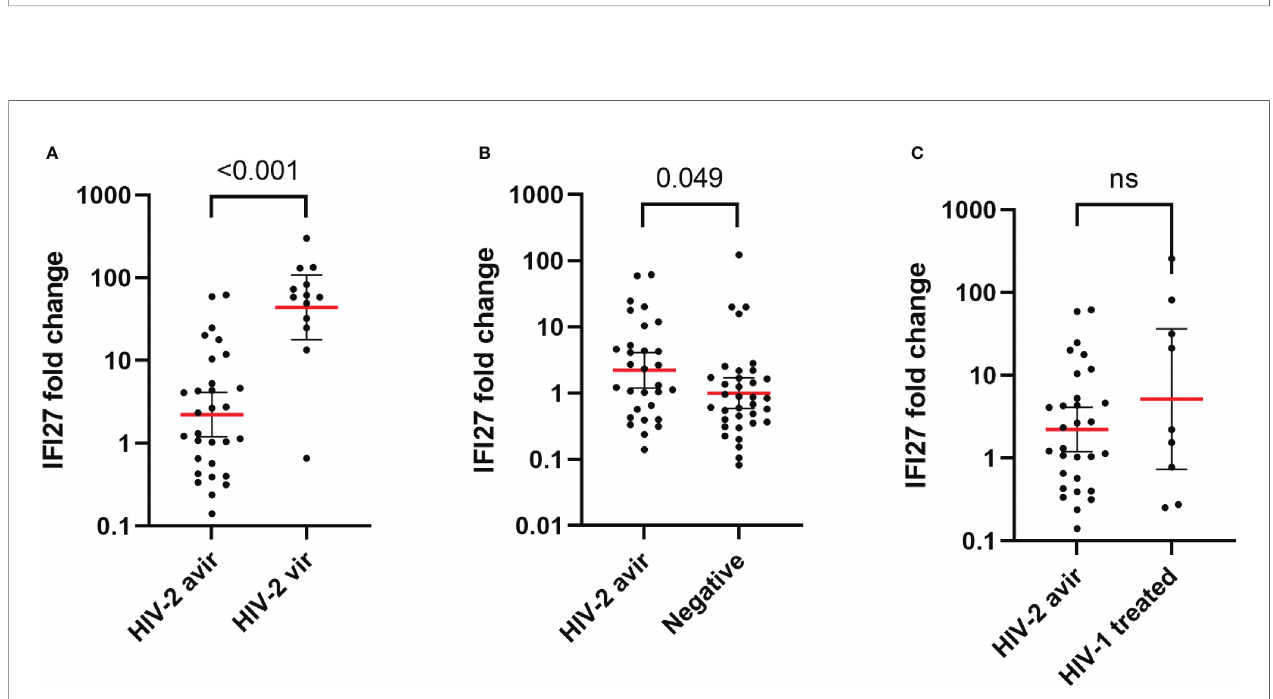
FIGURE 3 | IFI27 fold change expression in HIV-2 aviremic (n = 30) vs HIV-2 viremic (n = 13) (A) , HIV seronegative (n = 35) (B) , and HIV-1 successfully treated (C) (n = 9) individuals. The relative IFI27 fold change gene expression, compared to HIV seronegative controls, was quanti fi ed and calculated by qPCR and the 2^- DD CT method. The red line illustrates the geometric mean with con fi dence interval as error bars. IFI27 expression was log10-transformed prior to statistical comparison between groups using t-test. ns = non signi fi